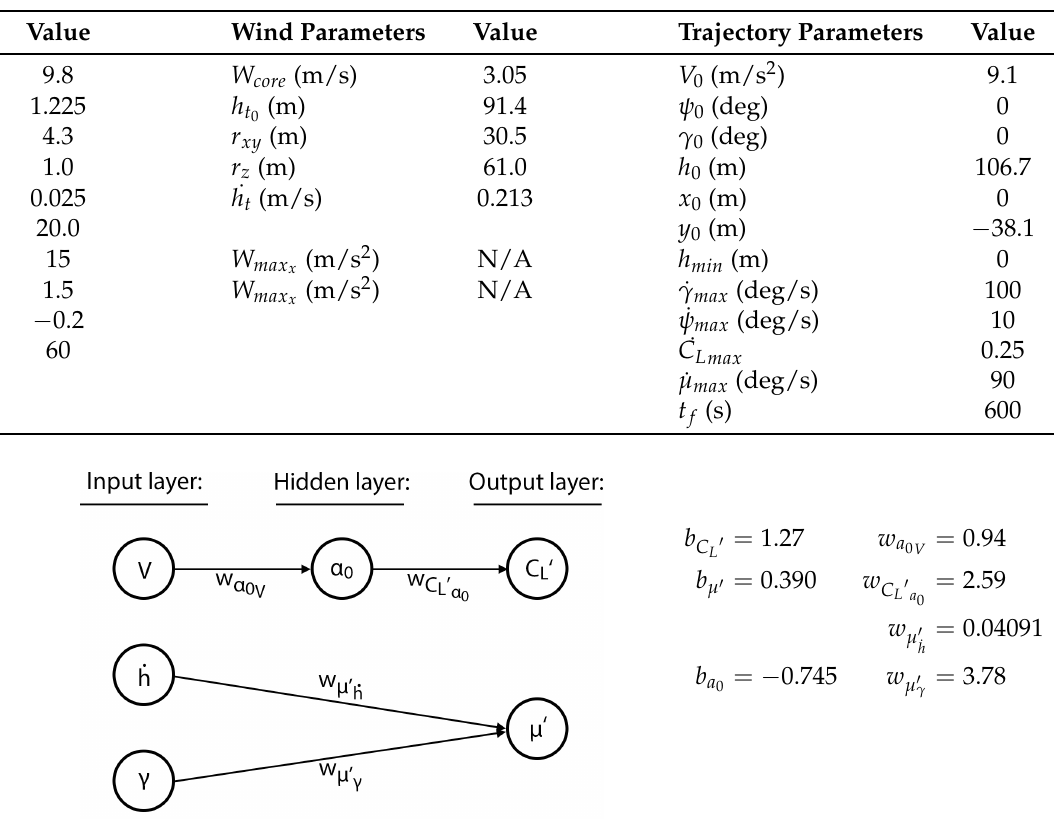
Table 4. Thermal soaring SUAV neurocontroller simulation parameters.